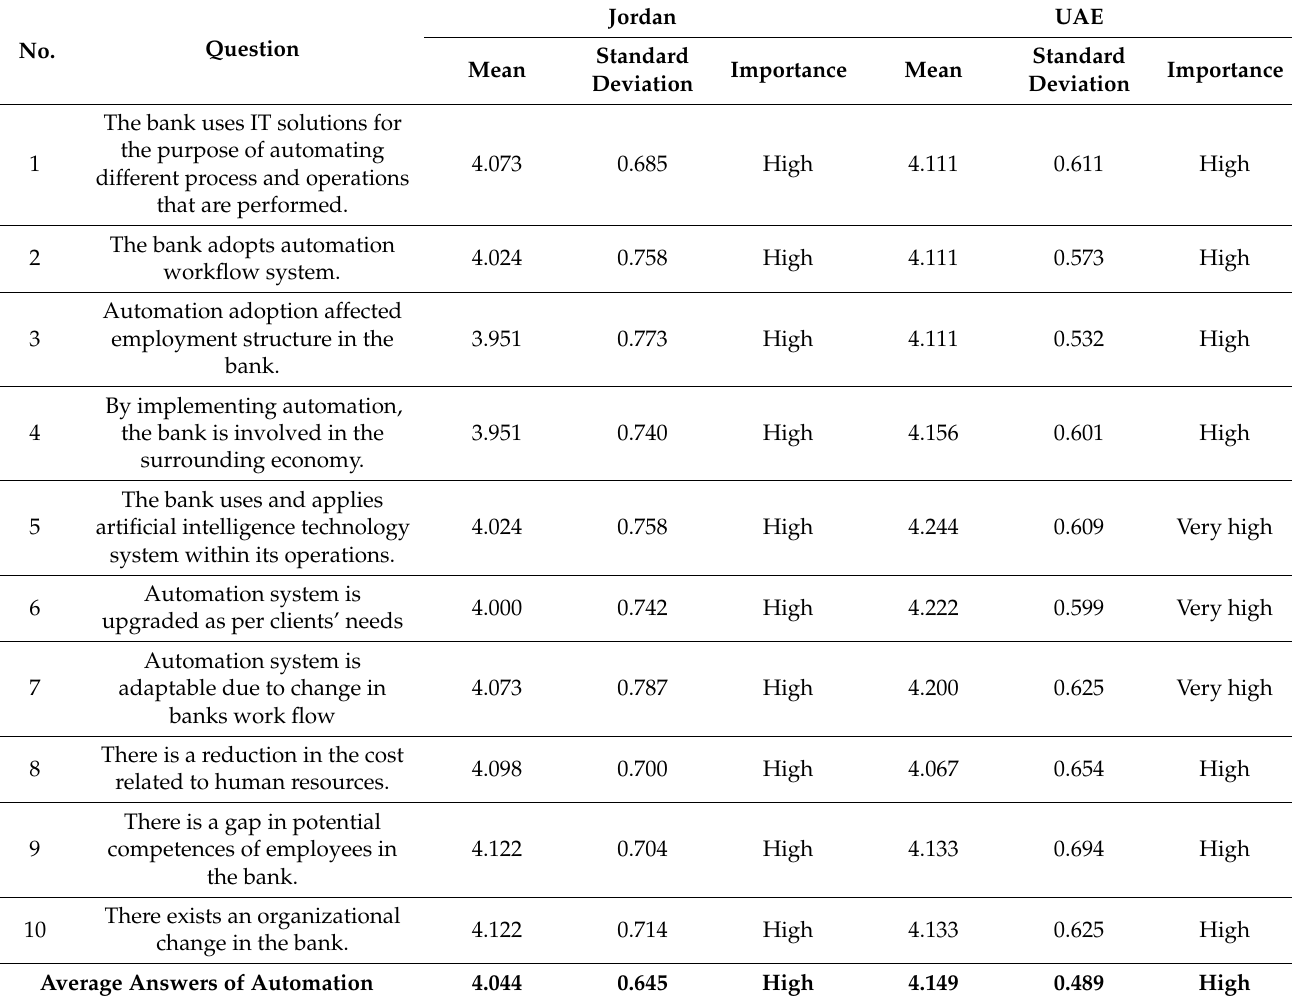
Table 4. Results of the Descriptive Analysis of the Independent Study Variable,